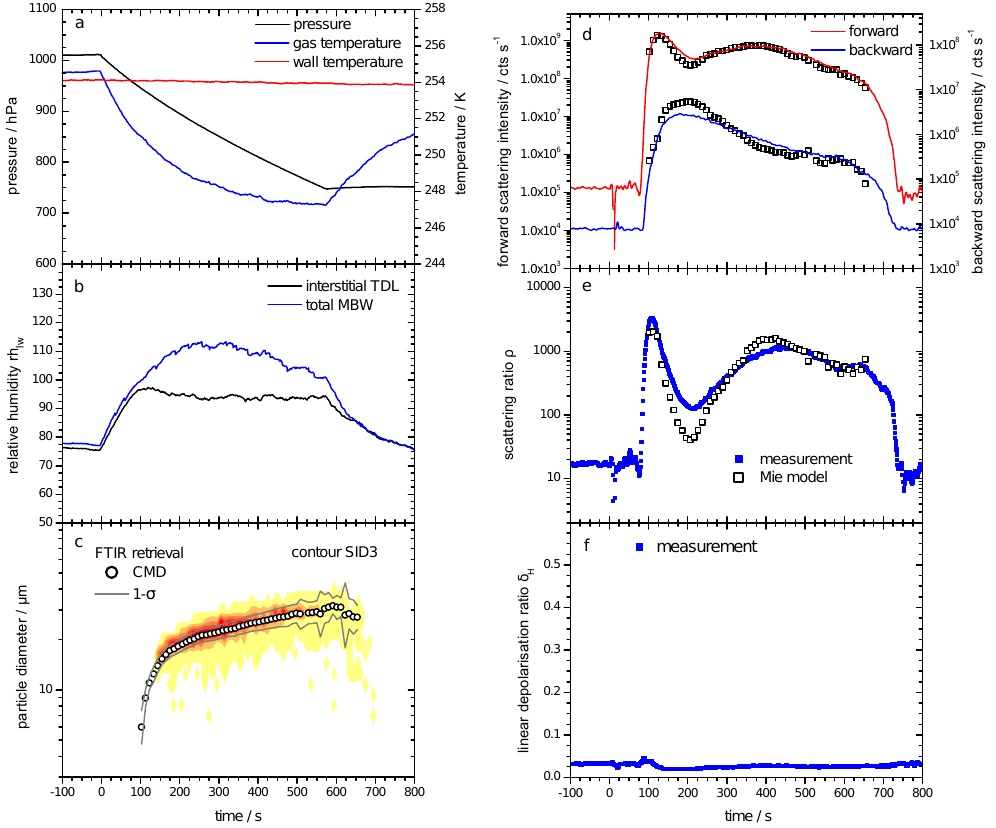
Fig. 6. Supercooled liquid cloud activation experiment HALO06 2. (a) Time evolution of the pressure and the mean gas and wall tempera- tures. (b) Relative humidities with respect to liquid water of the interstitial water vapour and the total (interstitial + condensed) water mass. (c) Comparison of the droplet size distributions retrieved from the FTIR extinction spectroscopy and deduced from SID3 single particle scattering patterns. (d–f) Comparison of the SIMONE measurement results with the results of the Mie analysis of the FTIR retrieved size distribution shown in (c) . Note that the modelled depolarisation value is zero throughout the cloud period and is, therefore, not depicted in (f)